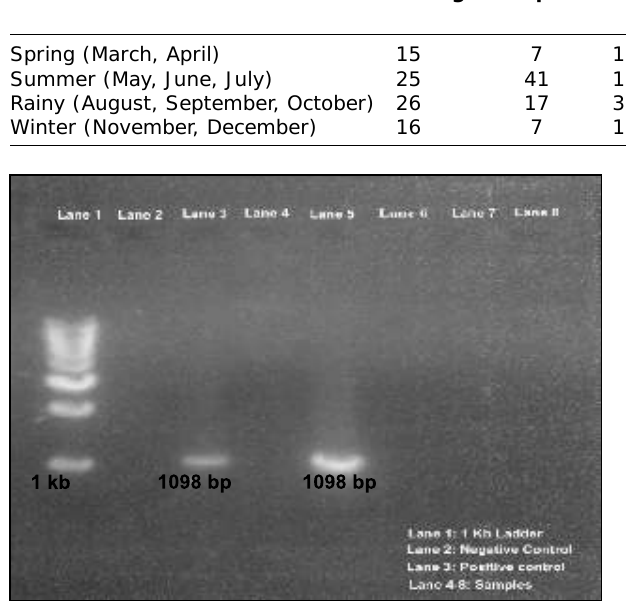
Figure-2. Microscopic Examination of Giemsa stained blood smear showing piroplasm of Theileria parasite (arrow shows the piroplasm stage of Theileria in erythrocyte) Table-1. Season-wise incidence of Theileria detected in crossbred cattle during March-December 2012 Season